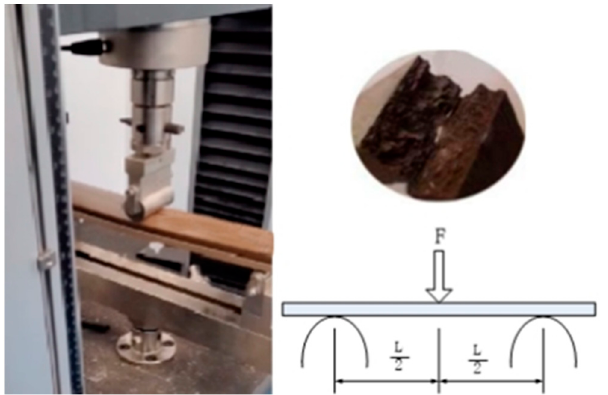
Figure 3. Destructive test.